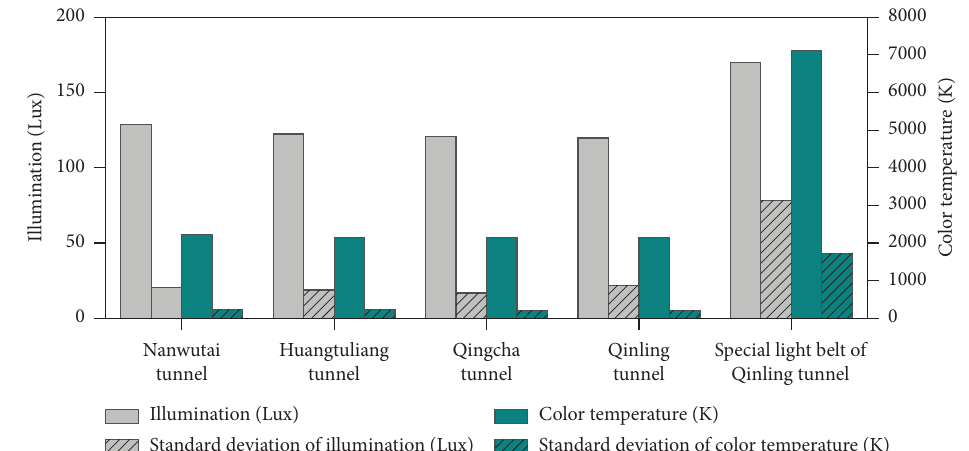
Figure 2: Lighting environment of the interior zones of each tunnel in the